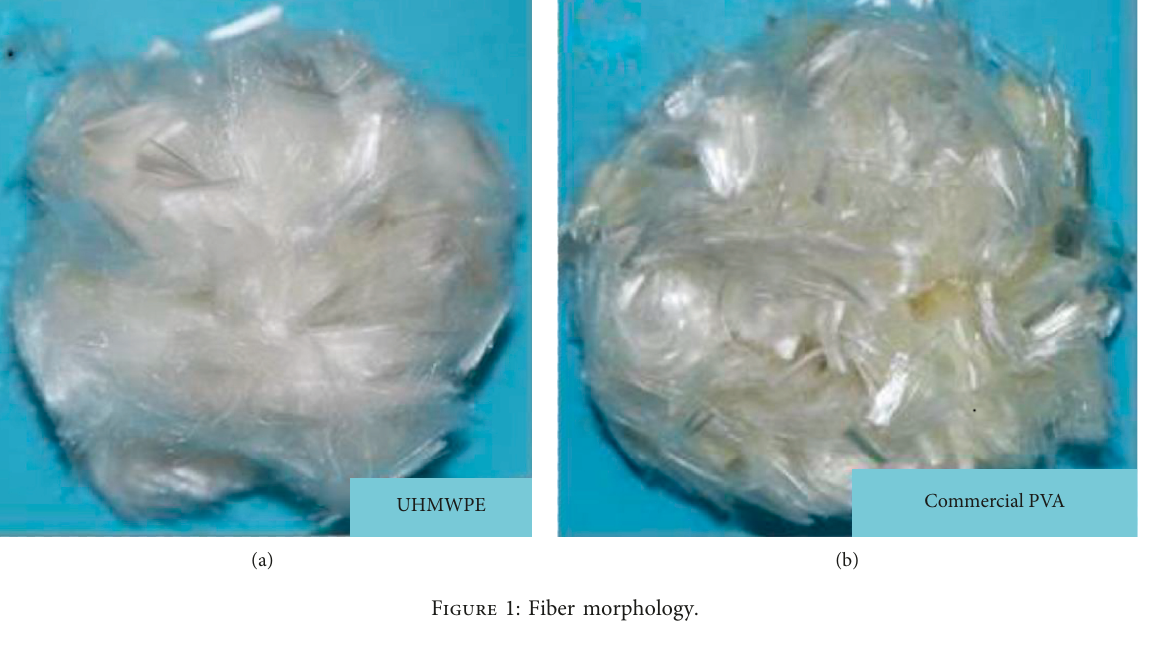
Figure 1: Fiber morphology.